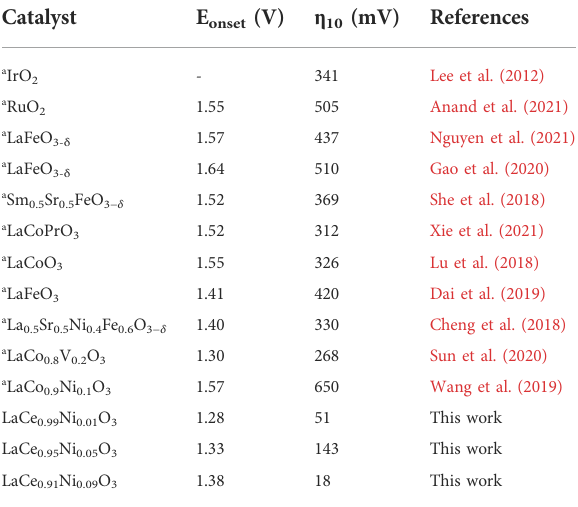
TABLE 3 Comparison of OER performance with literature reported data. Catalyst E onset